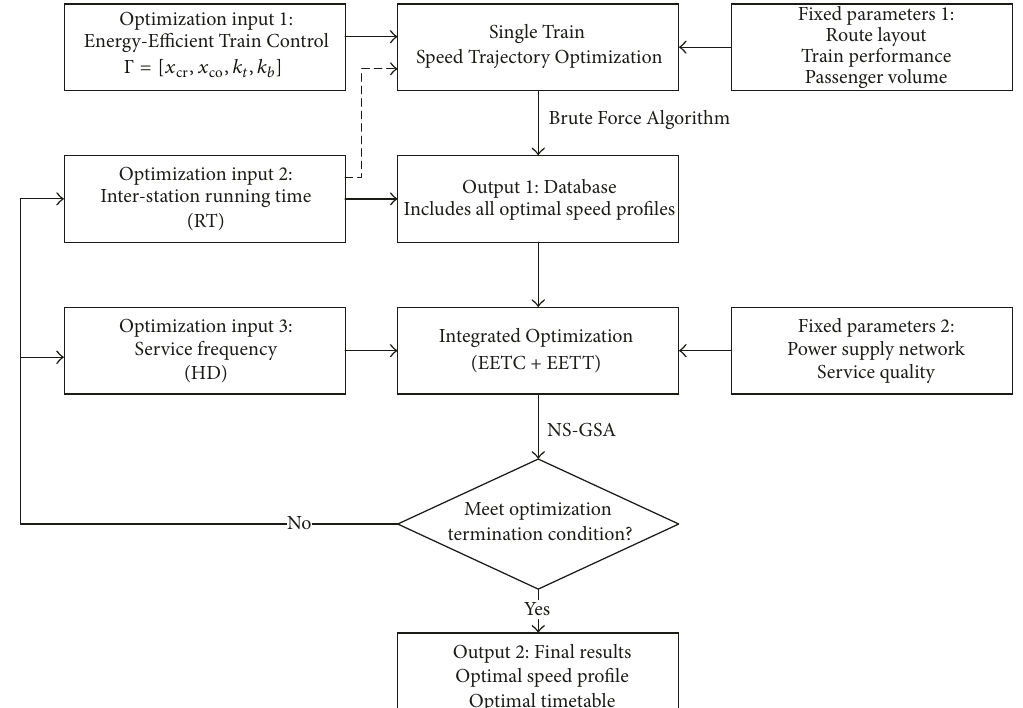
Figure 7: Flowchart of the integrated